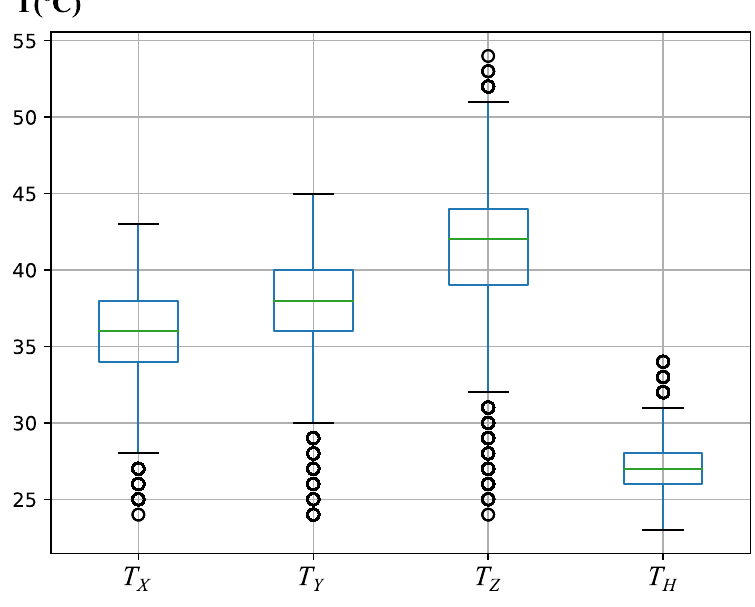
Figure 4. Box plots for temperature